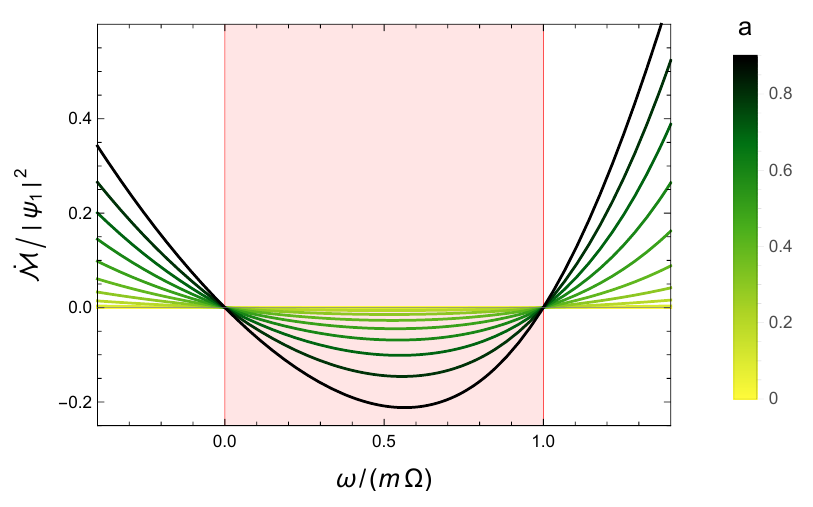
Figure 5 . The ω/ ( e Φ H ) dependence of the energy variation ˙ M / | ψ 1 | 2 for the black hole spins a = 0 , 0 . 1 , · · · , 0 . 9 . The superradiant condition is satisfied in the red